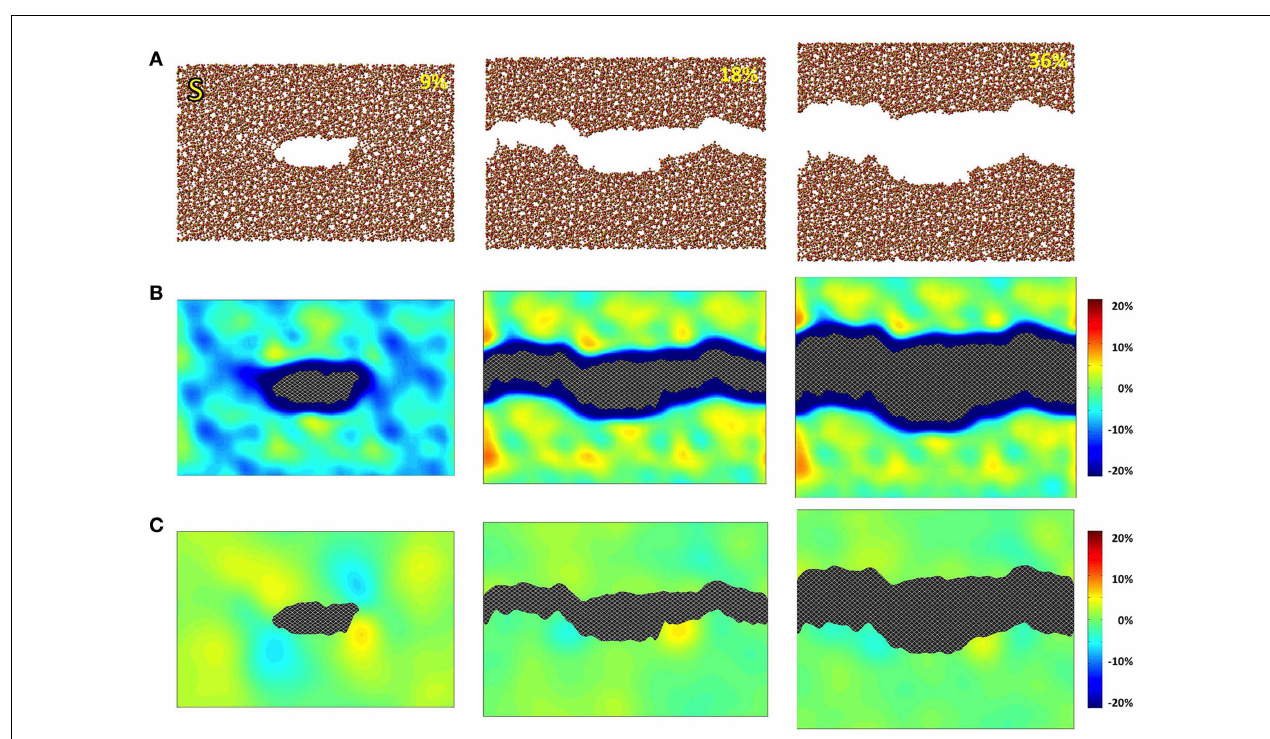
FIGURE 1 | Simulated silica (S) under 9, 18, and 36% strains . (A) Snapshots of the atomic configurations. Silicon and oxygen atoms are in gold and red, respectively; (B) local density change in percentage compared with the bulk density; (C) local shear